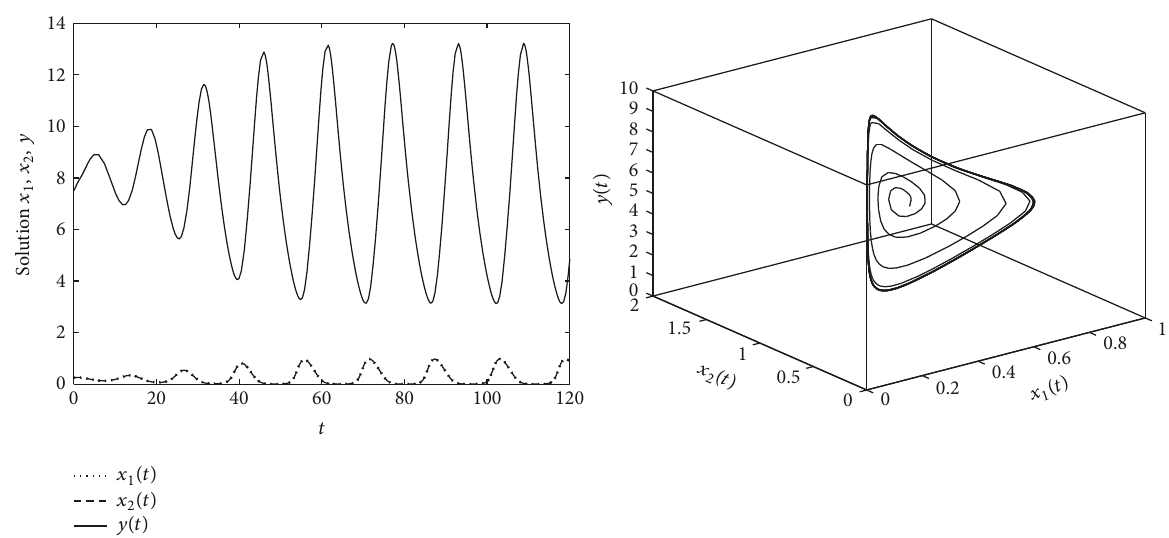
Figure 6: The behavior of 𝑥 1 , 𝑥 2 , and 𝑦 with respect to 𝑡 for equilibrium 𝐸 1 2 with 𝜏 = 2